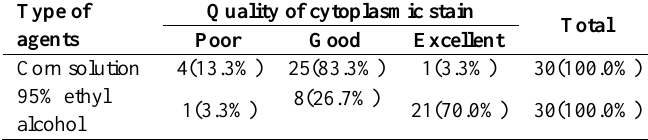
Table 2 : Effects of fixative in the quality of cytoplasmic